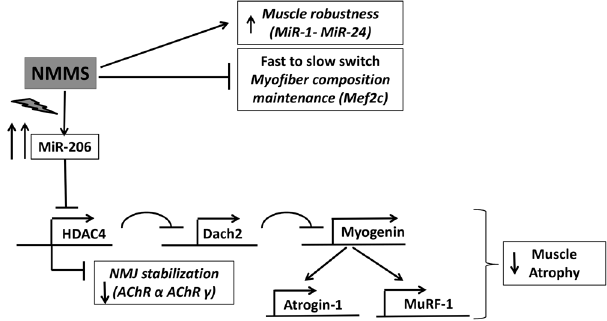
Figure 8. Schematic representation of NMMS effect on ALS muscle